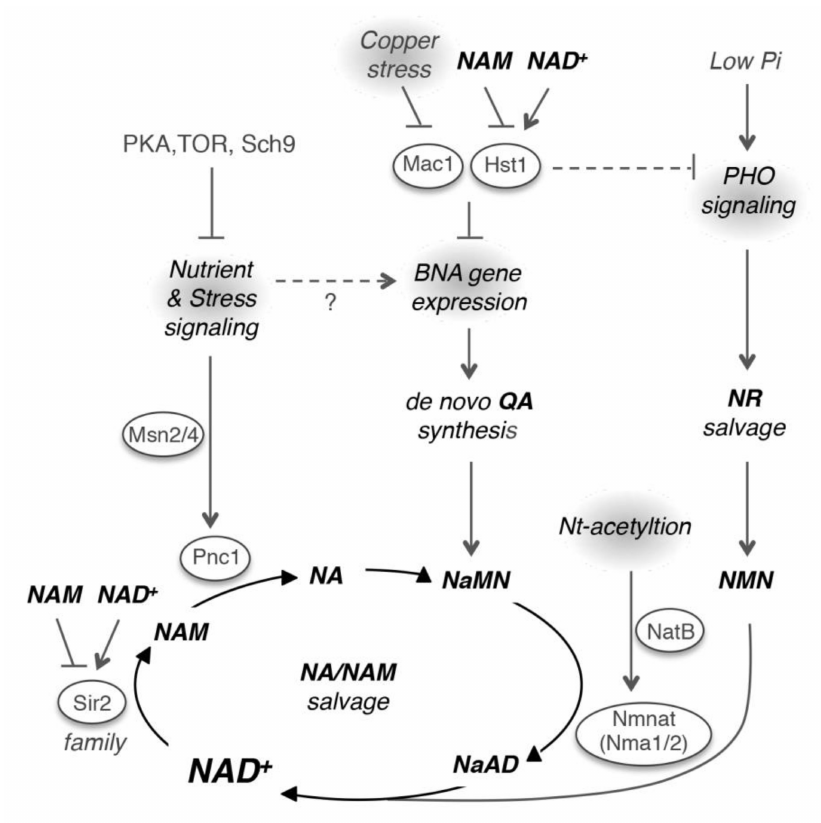
Figure 3. Regulation of NAD + metabolism in yeast. A model depicting the regulation of NAD +